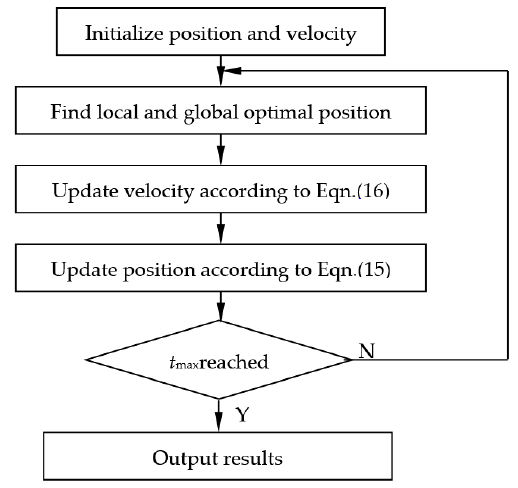
Figure 7. Flowchart of particle swarm optimization (PSO) method.